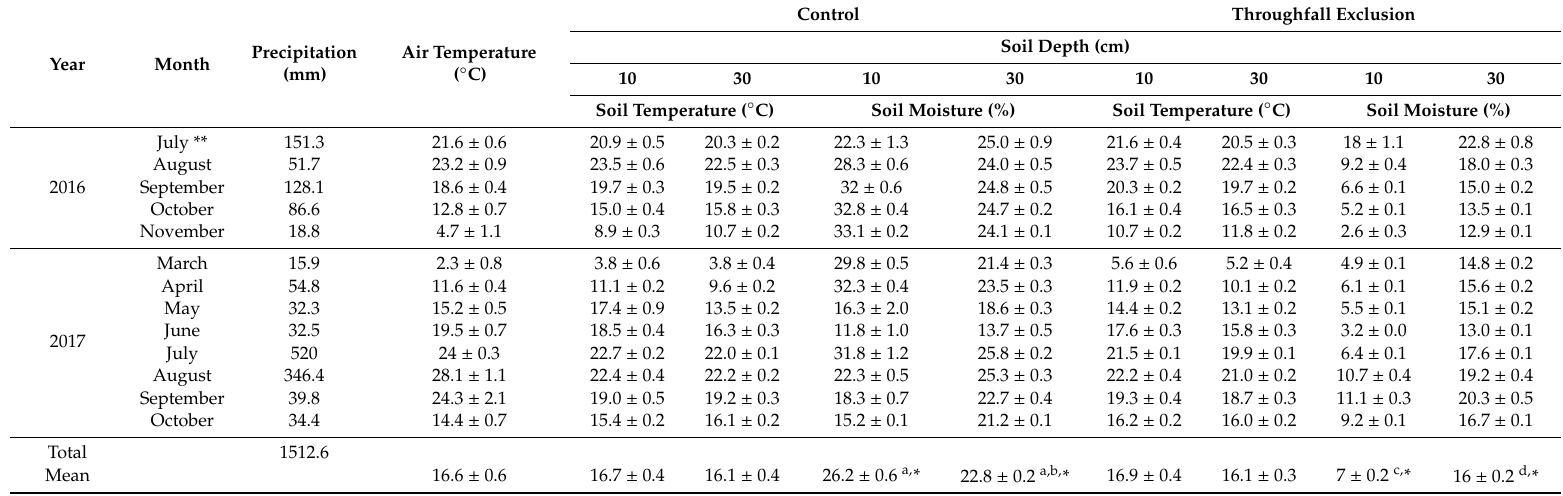
Table 3. Averages of soil water content, soil temperature with standard errors (Avg. ± S.E.) in the control and TFE plots during the TFE experiment.